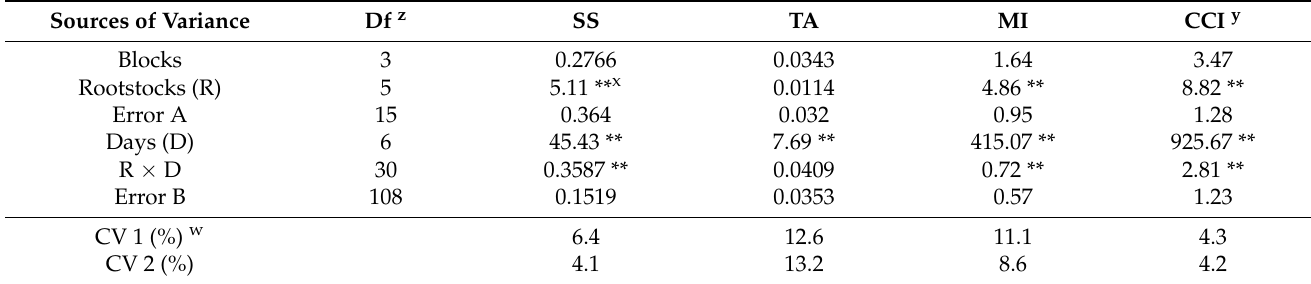
Table 1. Analysis of variance and mean squares of soluble solids (SS), titratable acidity (TA), maturation index (MI) or ratio , and citrus color index (CCI) over time of ‘Valencia’ orange fruits when trees are grafted on different ‘Trifoliata’ hybrid rootstocks at Rancho